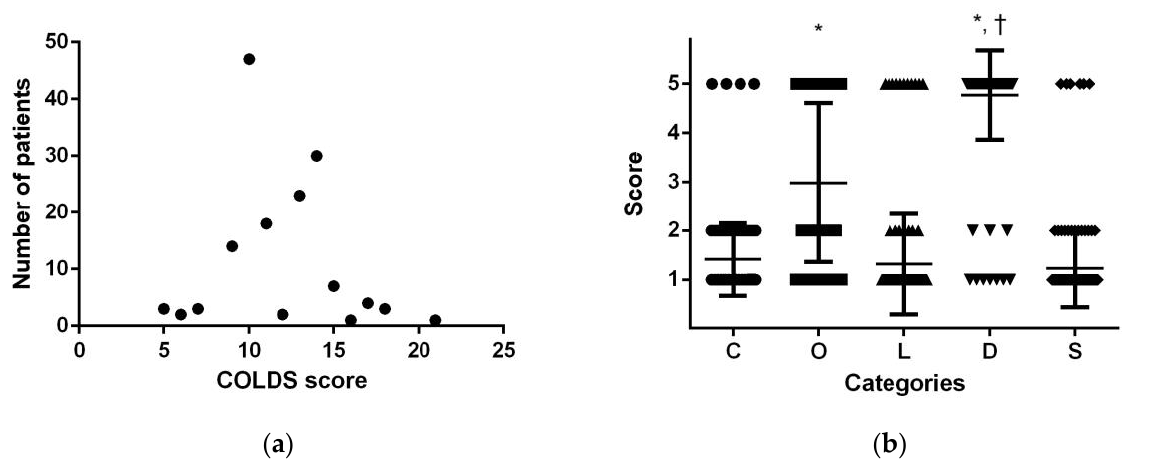
Figure 1. Graphs depicting the occurrence of perioperative respiratory adverse events (PRAEs) according to COLDS score. ( a ) Number of patients who suffered PRAEs according to COLDS score. ( b ) Description of each COLDS category in the patients with PRAEs. The five components of the COLDS score did not contribute equally to the total score. Total COLDS scores were contributed in the order of “D”, “O”, and the others. * p < 0.05 compared to “C”, “L”, or “S”, † p < 0.05 compared to “O”.